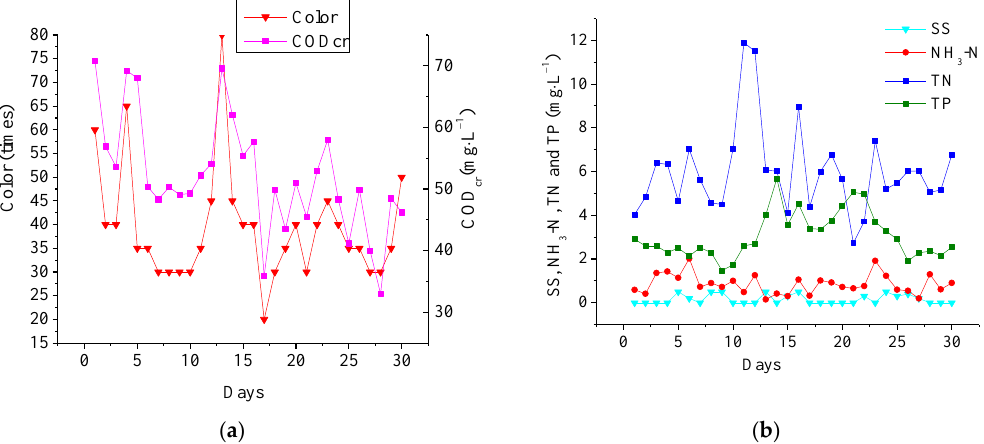
Figure 5. Pollutants of the effluent after treatment by the reaction, precipitation, primary sand filtration, primary ozone oxidation, and secondary sand filtration ( a ) chemical oxygen consumption (COD cr) and color, ( b ) suspended solid (SS), NH 3 − N, TN and TP .